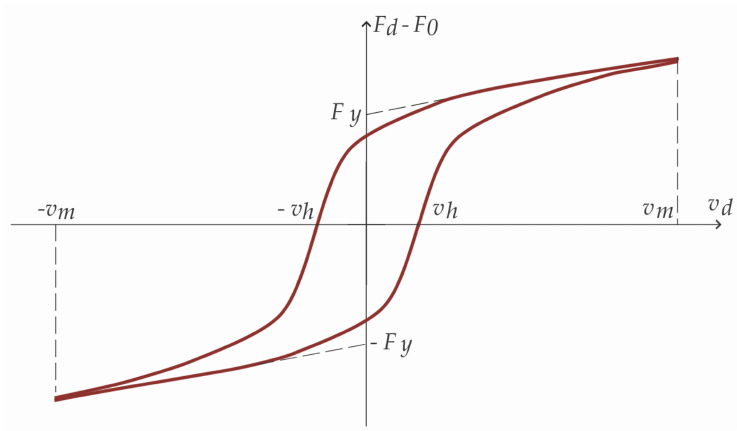
Figure 15. The hysteretic regularized Bingham model